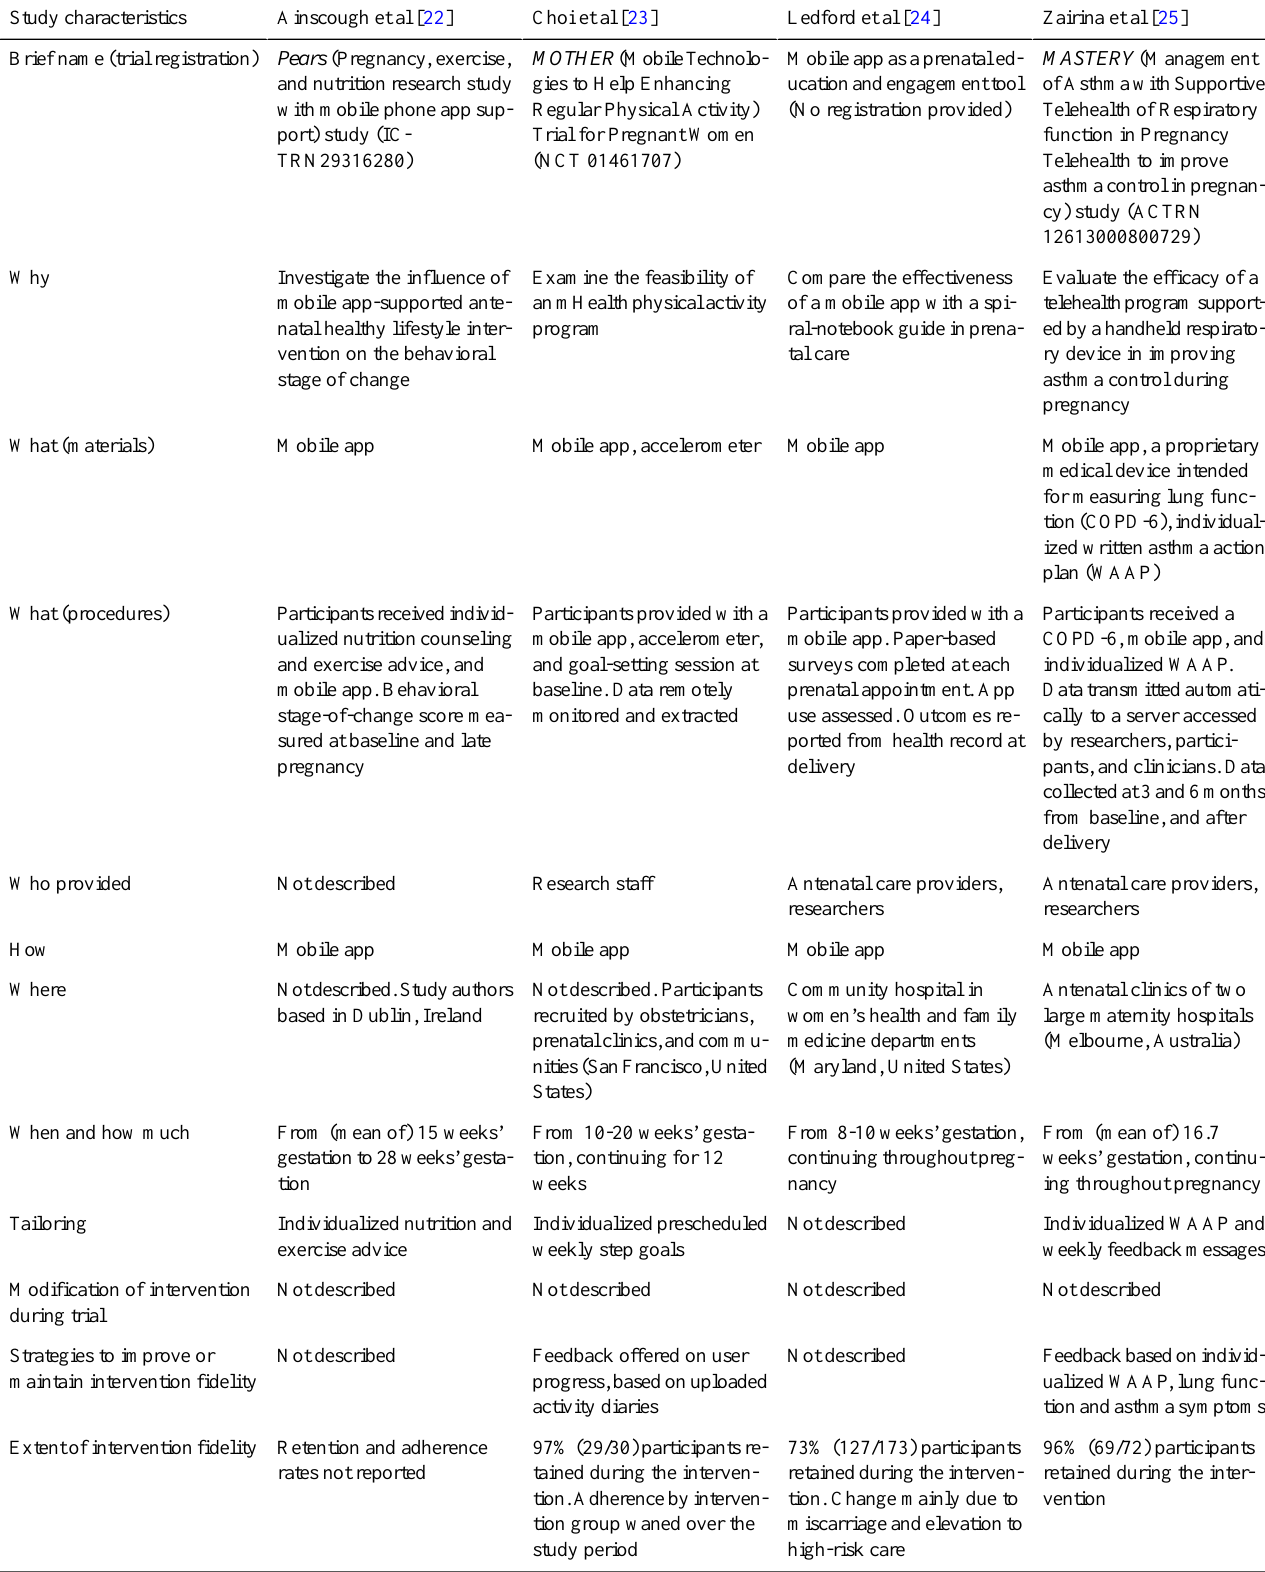
Table 4. Intervention features by the Template for Intervention Description and Replication (TIDieR)